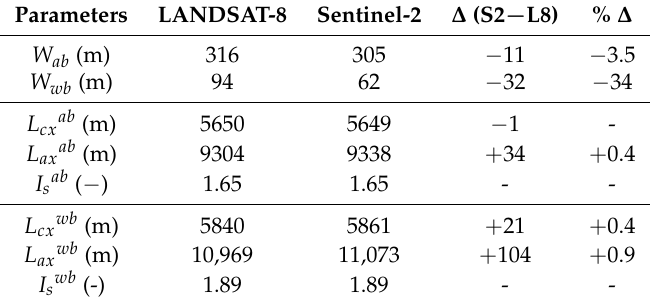
Table 10. Comparison of the results obtained with LANDSAT-8 and Sentinel-2 imagery of the Vjosë River, sensed in the summer of 2017; active ( · ab ) and wet ( · wb ) channel widths, Cartesian ( · cx ) and axial ( · ax ) lengths ( L ) and sinuosity indexes ( I ).